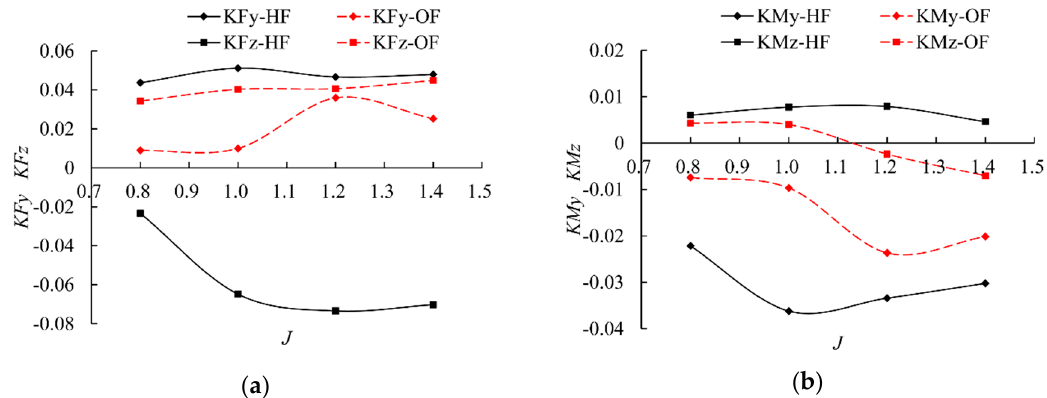
Figure 13. Forces / moments acting on SPP-1 in horizontal (HF) and oblique flow (OF). ( a ) Forces acting on SPP-1 in horizontal (HF) and oblique flow (OF); ( b ) moments acting on SPP-1 in horizontal (HF) and oblique flow (OF).